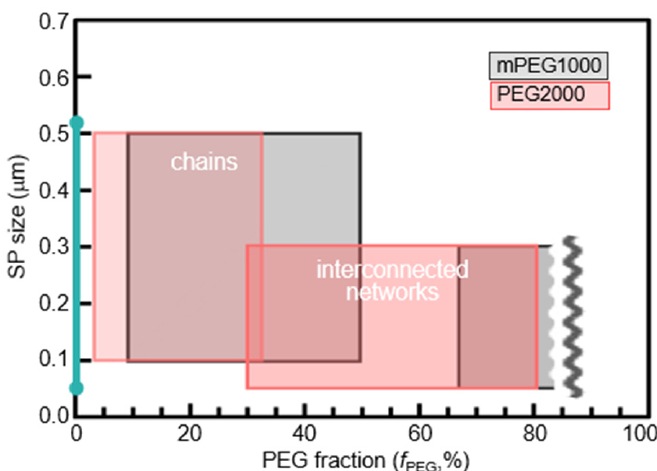
Figure 4. Sizes of SPs and morphologies of micro- and macrostructures formed at different PEG fractions and lengths.